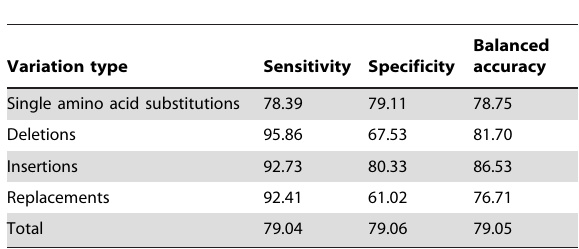
Table 2. Prediction accuracy for the UniProt human protein variations given a PROVEAN score threshold of 2